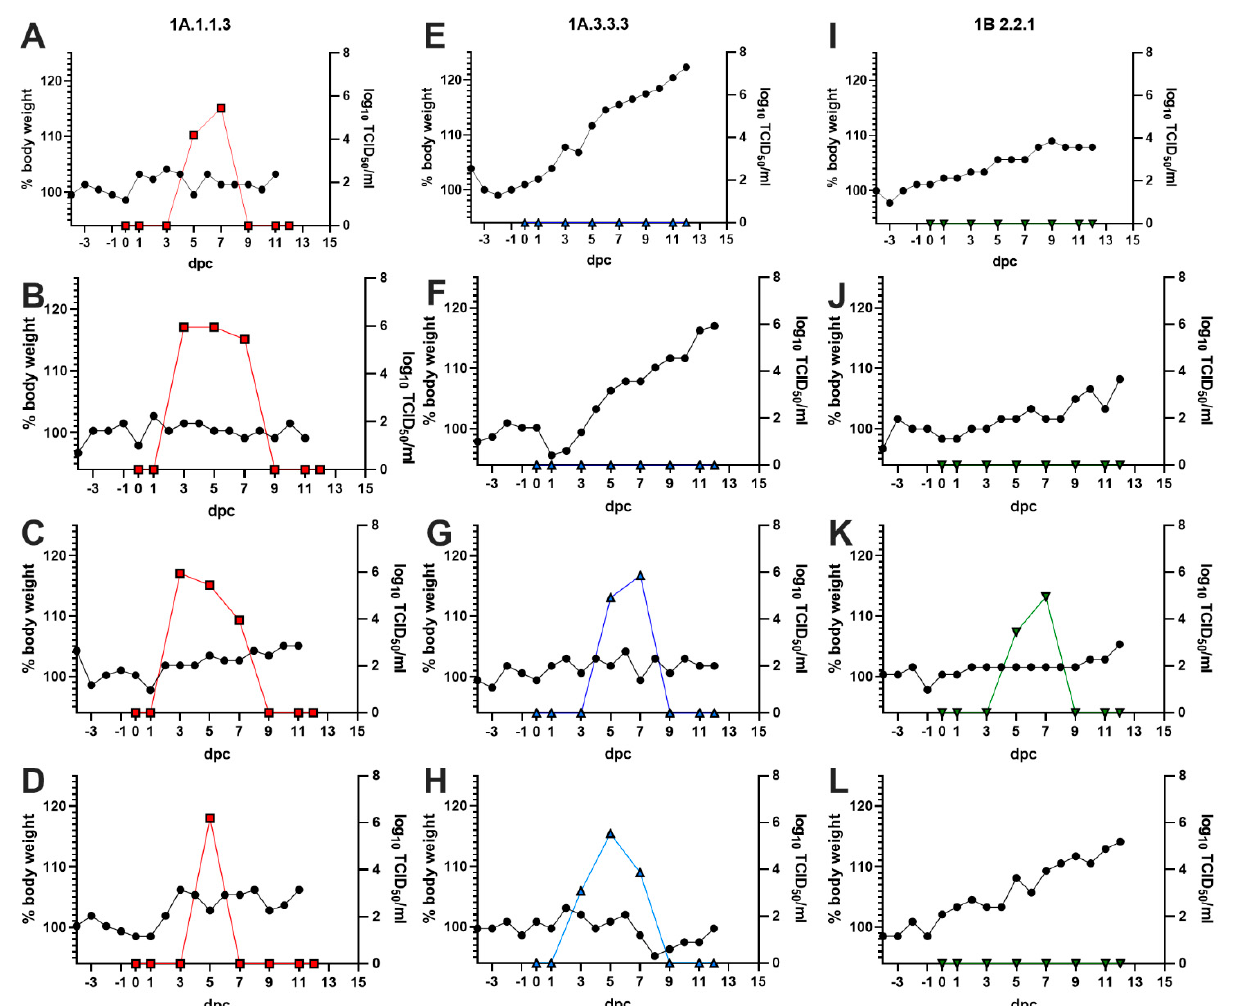
Figure 3. Transmission and replication of swine viruses to ferrets. Individual ferrets exposed to pigs infected with a 1A.1.1.3 (( A – D ), red squares), 1A.3.3.3 (( E – H ), blue up-triangles) or 1B.2.2.1(( I – L ), green down-triangles) had body weights recorded daily and converted to a percentage of the 3-day average body weight prior to exposure with 100% being baseline (left axis, black circles). Nasal washes were measured for viral shedding in MDCK cells and recorded as log 10 TCID 50 /mL (right axis, color shape).